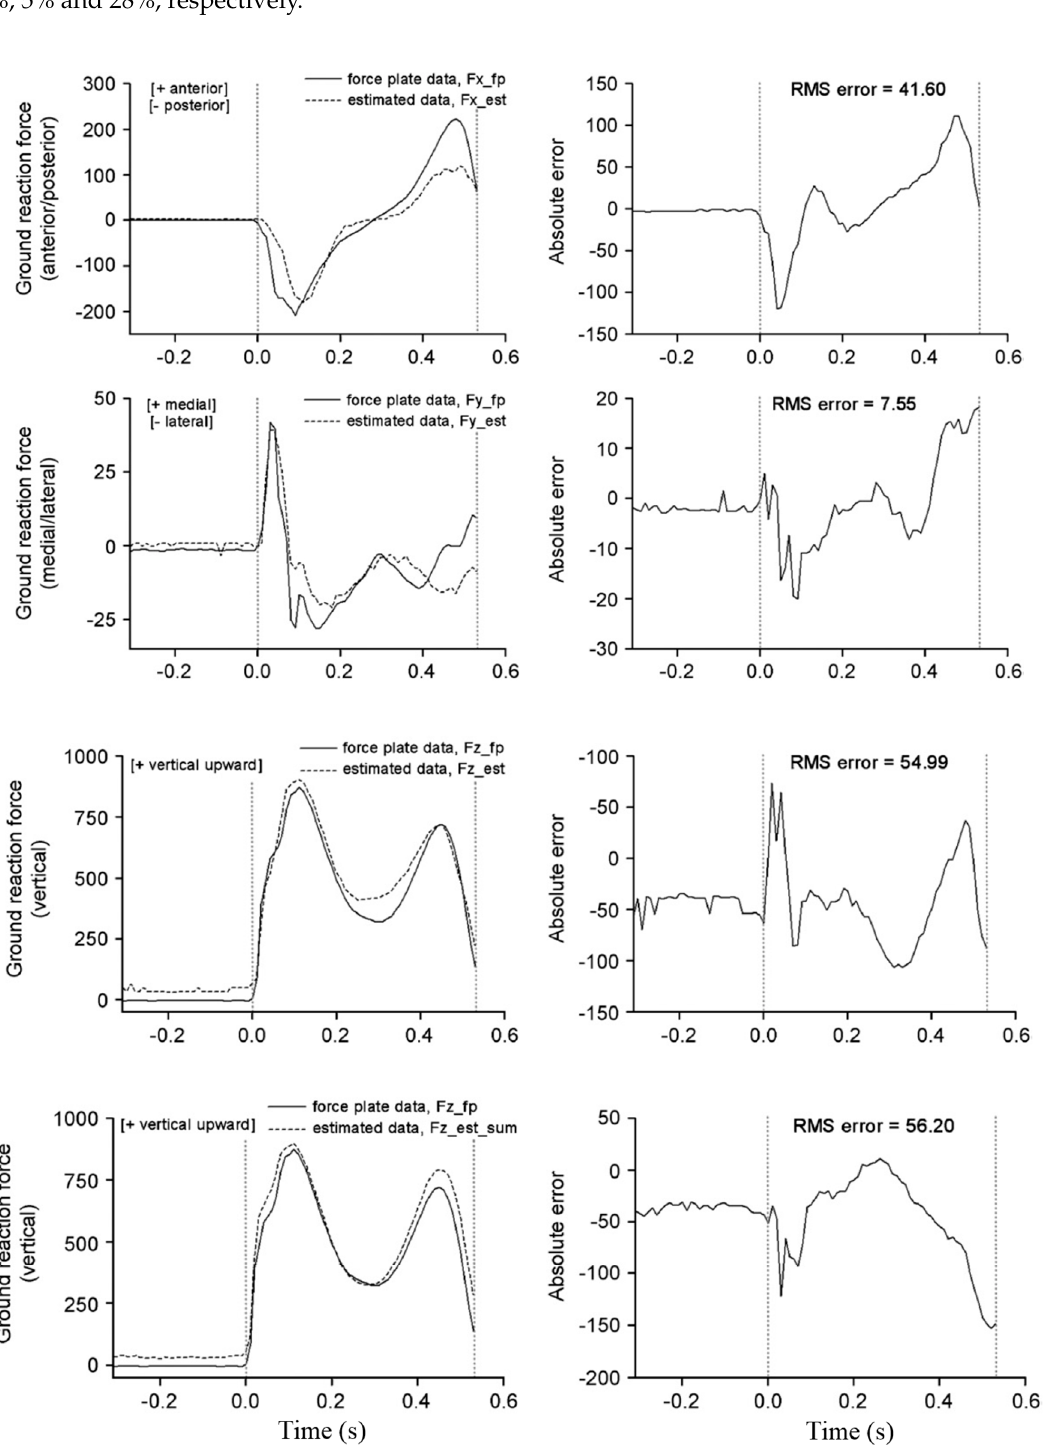
Figure 11. Comparison of the estimated 3D GRFs (dashed line) with corresponding forceplate measurements (solid line) (after [64]).